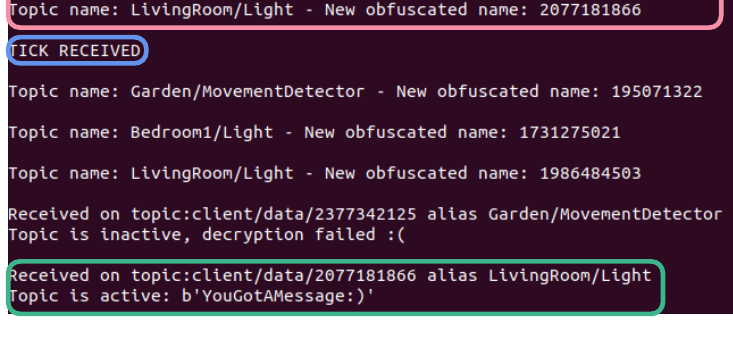
Figure 8. Subscriber’s view.